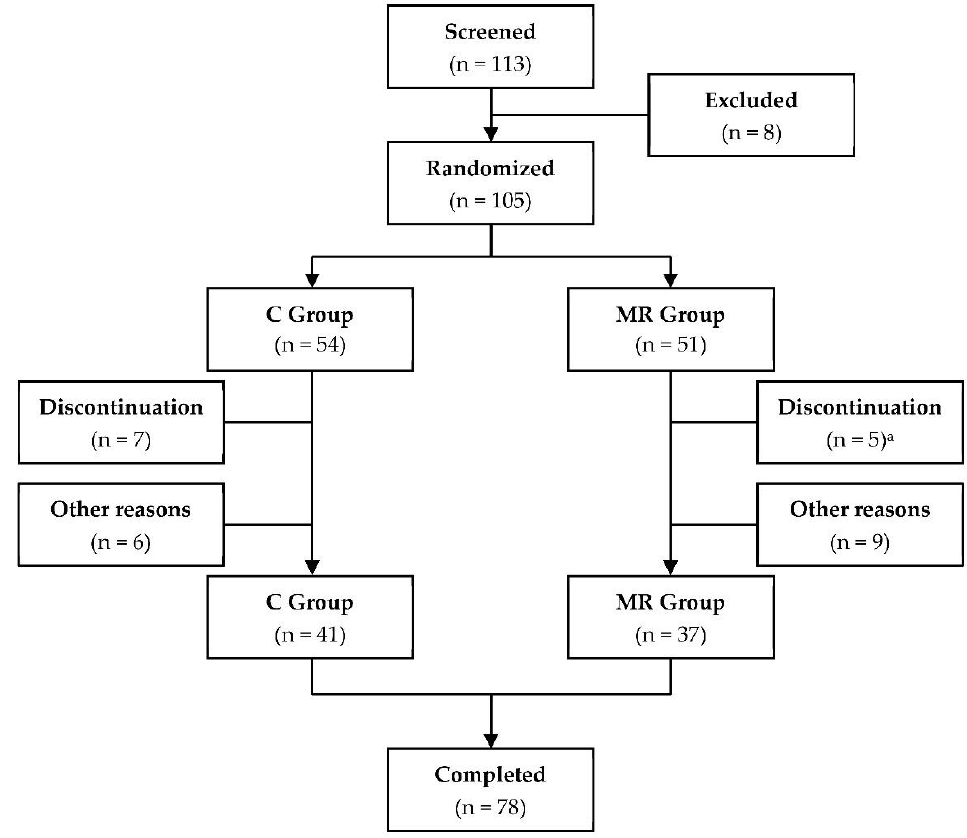
Figure 1. Trial profile. Abbreviations: C, control; MR, meal replacement; a one adverse event. Baseline characteristics did not differ between both groups (Table 1). Approximately 75% of women in both groups had obesity stage I (30.0 – 34.9 kg/m 2 ) or stage II (35.0 – 39.9 kg/m 2 ).